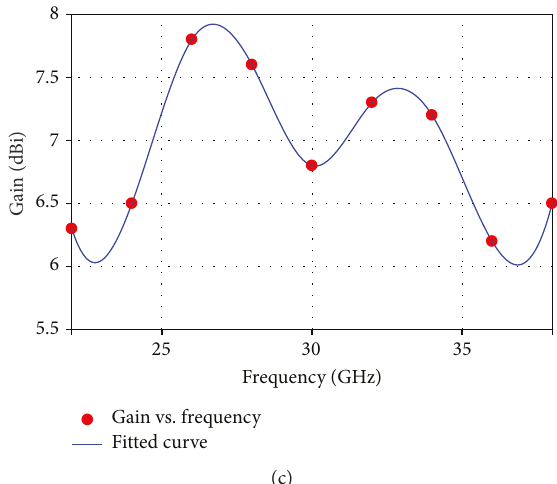
Figure 7: Simulated 3-D radiation patterns of the 3 × 3 MIMO antenna at (a) 28 GHz and (b) 32 GHz, simulated gain of single element of the proposed MIMO antenna.